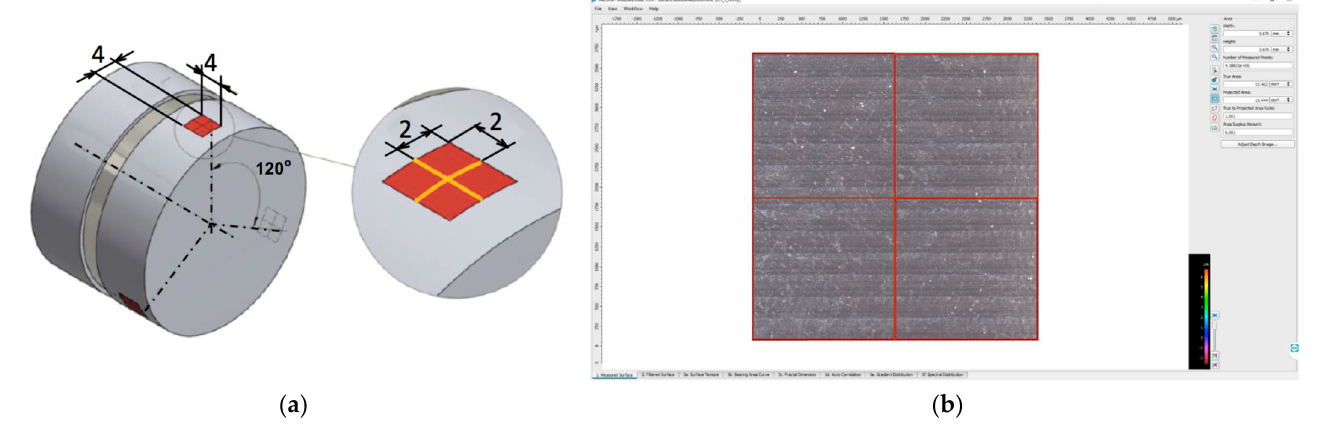
Figure 4. Measurement of the surface topography parameters: ( a ) scanned area on the bearing surface; ( b ) example of the screen during measurement, where red lines divide the scanned area into four analyzed sections.